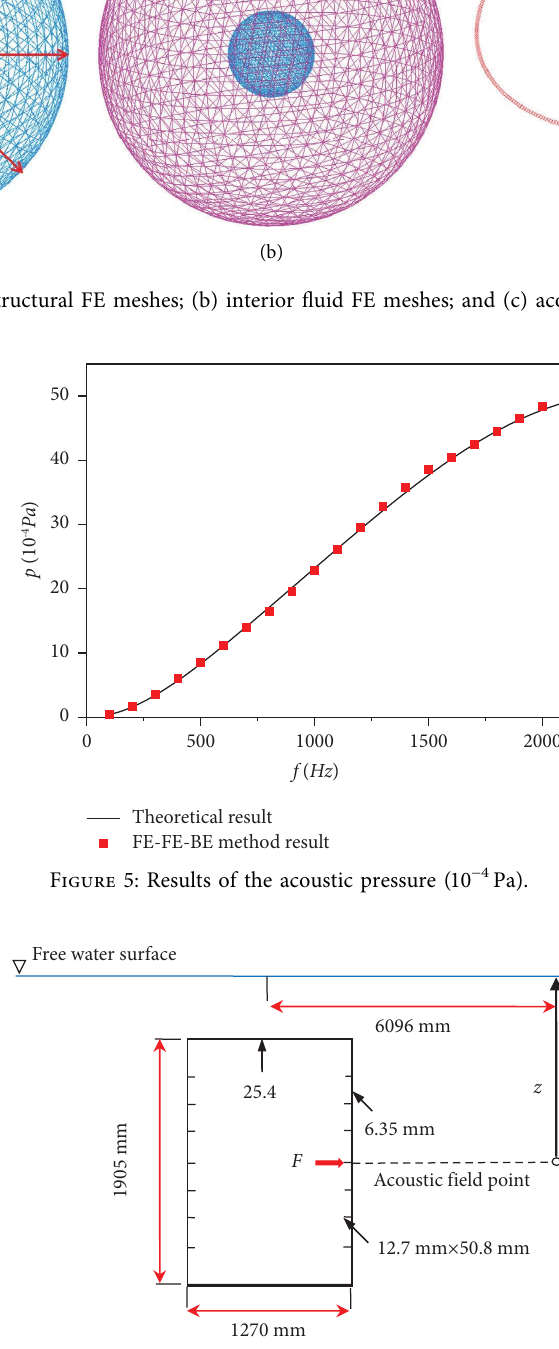
Figure 6: Geometry of the ribbed cylindrical shell and underwater